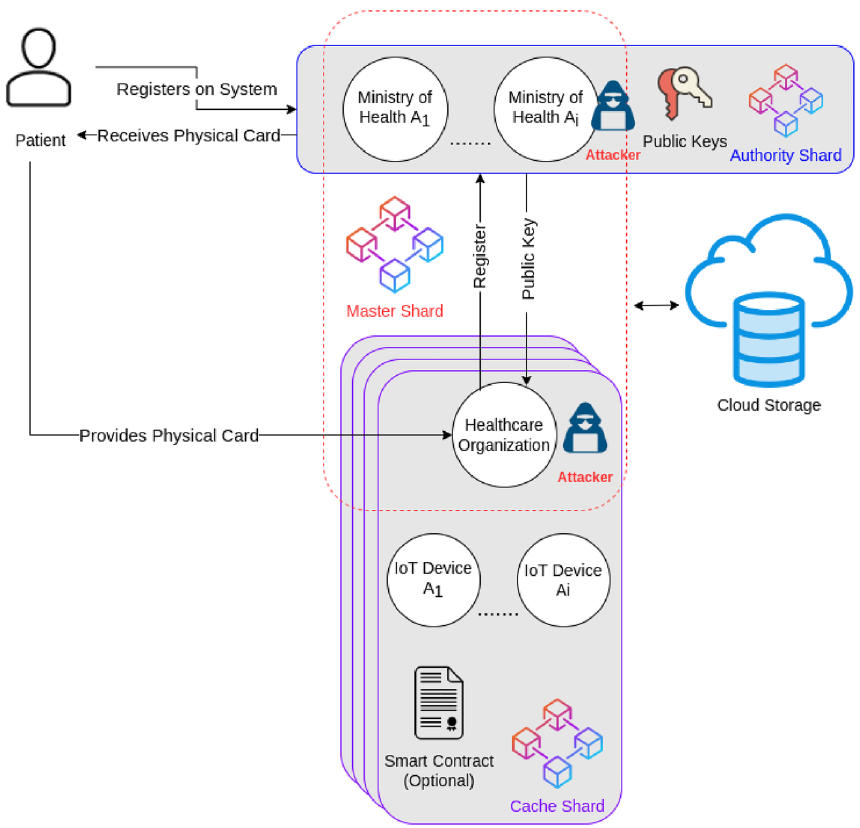
Figure 11. Attacker model of the